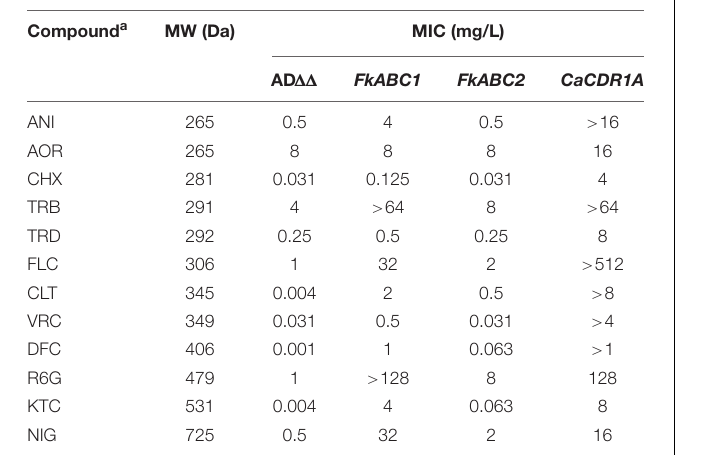
( Table 3 and Supplementary File 1 ). Among the full-size PDR transporters all four FSSC species had two cluster F and three cluster H1 PDR transporter orthologues. However, the number of cluster B, C and H2 PDR transporters varied significantly between individual species. FSSC10 had 4, 1, and 1, FSSC5 had 8, 3, and 4, FSSC11 had 9, 2, and 4 and N. haematococca had 9, 3, and 4 cluster B, C, and H2 PDR transporters, respectively ( Table 4 and Supplementary File 1 ). The conservation of two soluble ABCG protein orthologues ( CAF16 , MODF ), three “half- size” ABCG transporter orthologues (Ca19.3120, 2 ADP1 ) and five full-size cluster F (2 YOL075C) and H1 (3) PDR transporters suggests an important function for these 10 ABCG proteins that appear to be conserved among all FSSC species. In contrast,